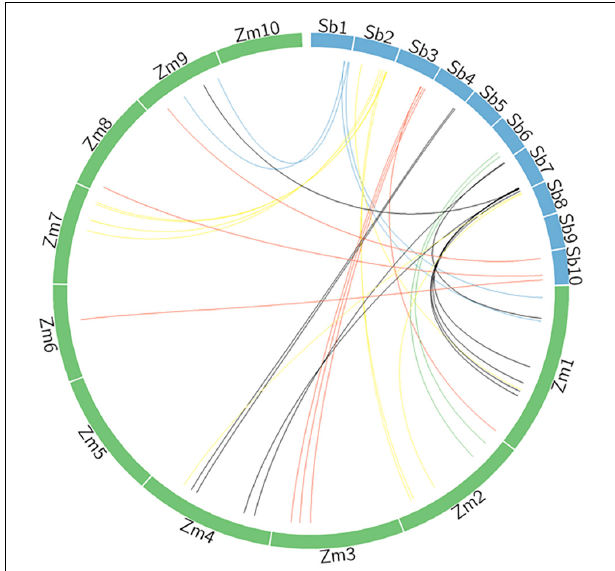
FIGURE 4 | Syntenic relationship of sorghum genomic regions associated for traits under study with maize genome.